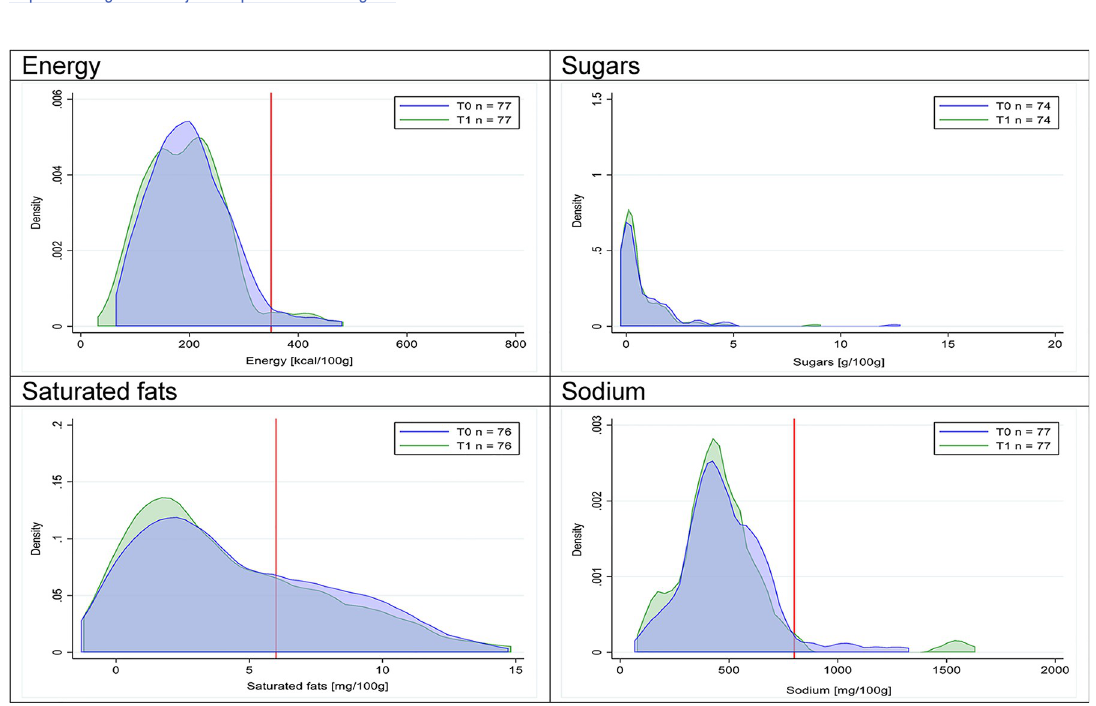
Fig 32. Density curves for the amount of energy and nutrients of concern in nonsausage meat products, longitudinal subsample. The blue line represents the distribution in T0 (preimplementation), the green line represents the distribution in T1 (postimplementation), and the red line represents the cutoff for the amount of energy or nutrients of concern.